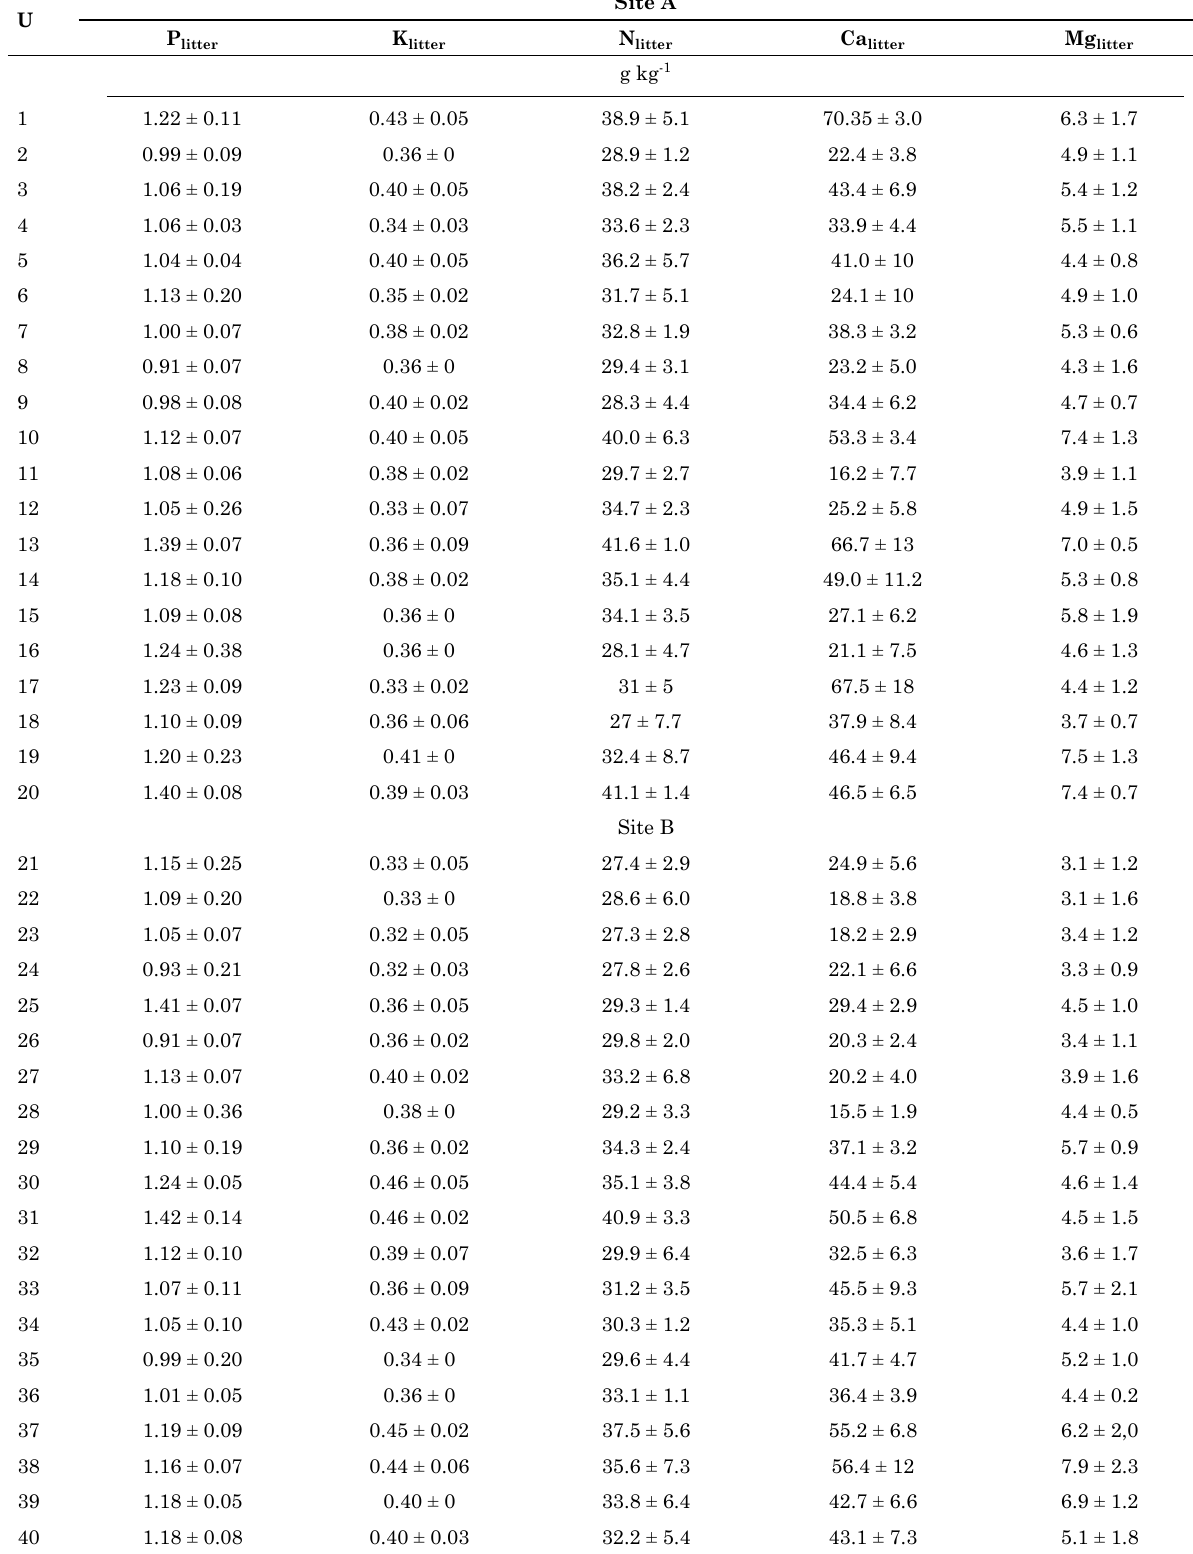
table 3. Mean and standard deviation for litter concentration of the p, K, n, Ca, and Mg for each sampling unit (u) at sites a and b with greater and lower exposure to incident solar radiation, respectively, on Marambaia island